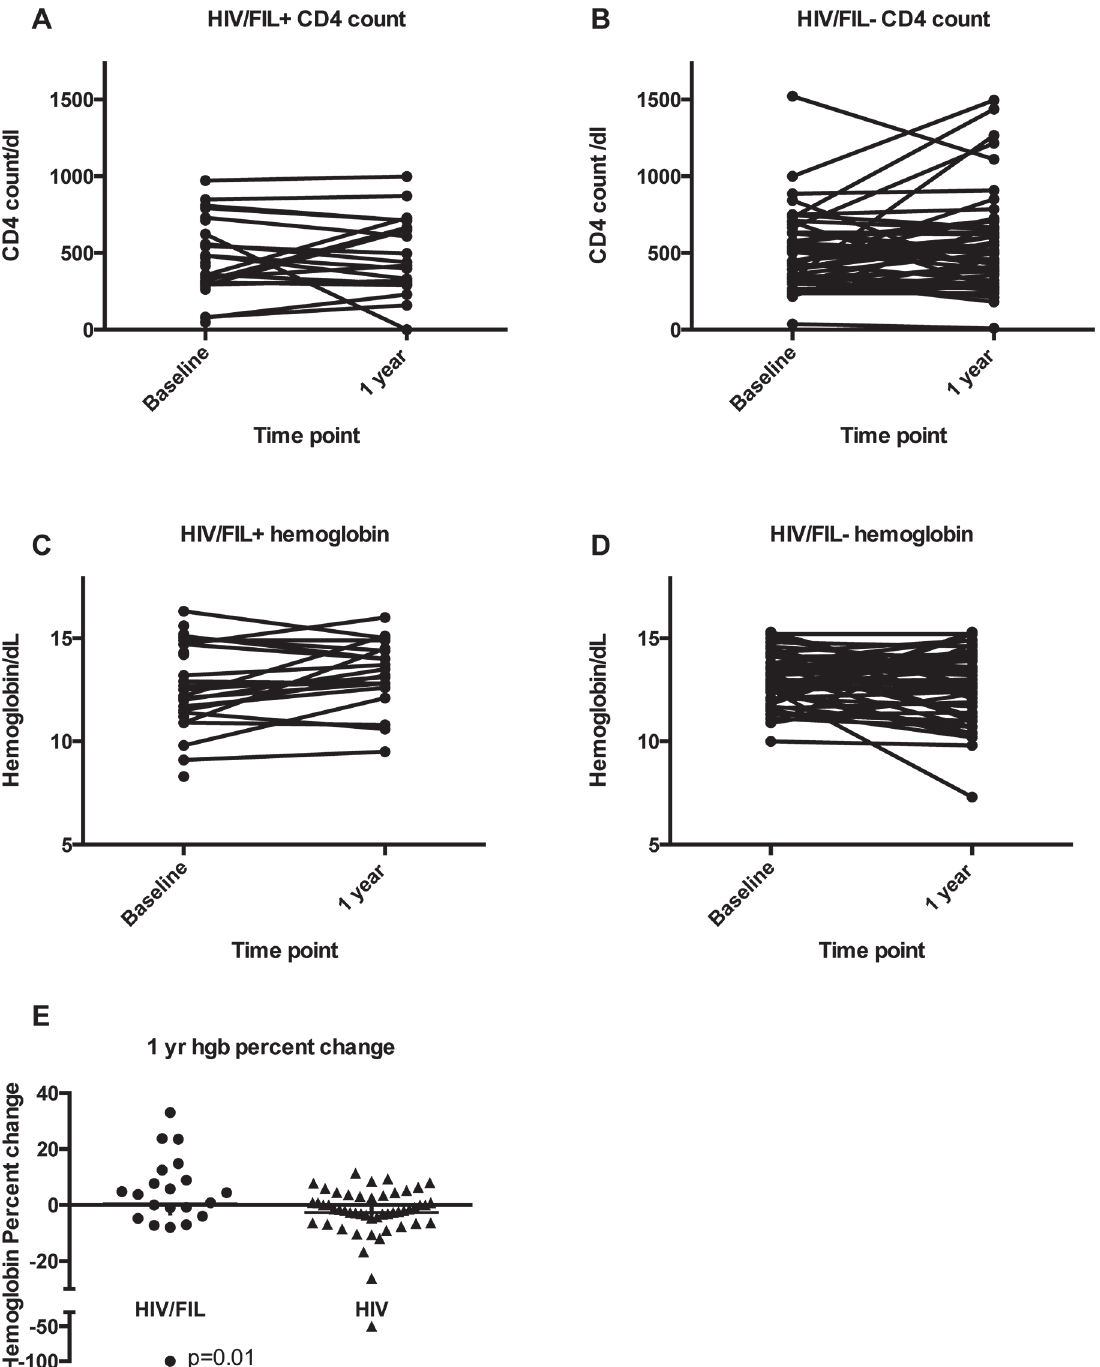
Fig 4. CD4 counts and hemoglobin levels over time. CD4 counts ( A and B ) and Hemoglobin levels (Hgb) ( C and D ) at baseline and 1 year between HIV+ / FIL+ individuals ( A , C ) and HIV+/FIL- individuals ( B , D ). E . Hemoglobin percent change at 1 year between HIV+/FIL+ and HIV+/FIL- individuals.